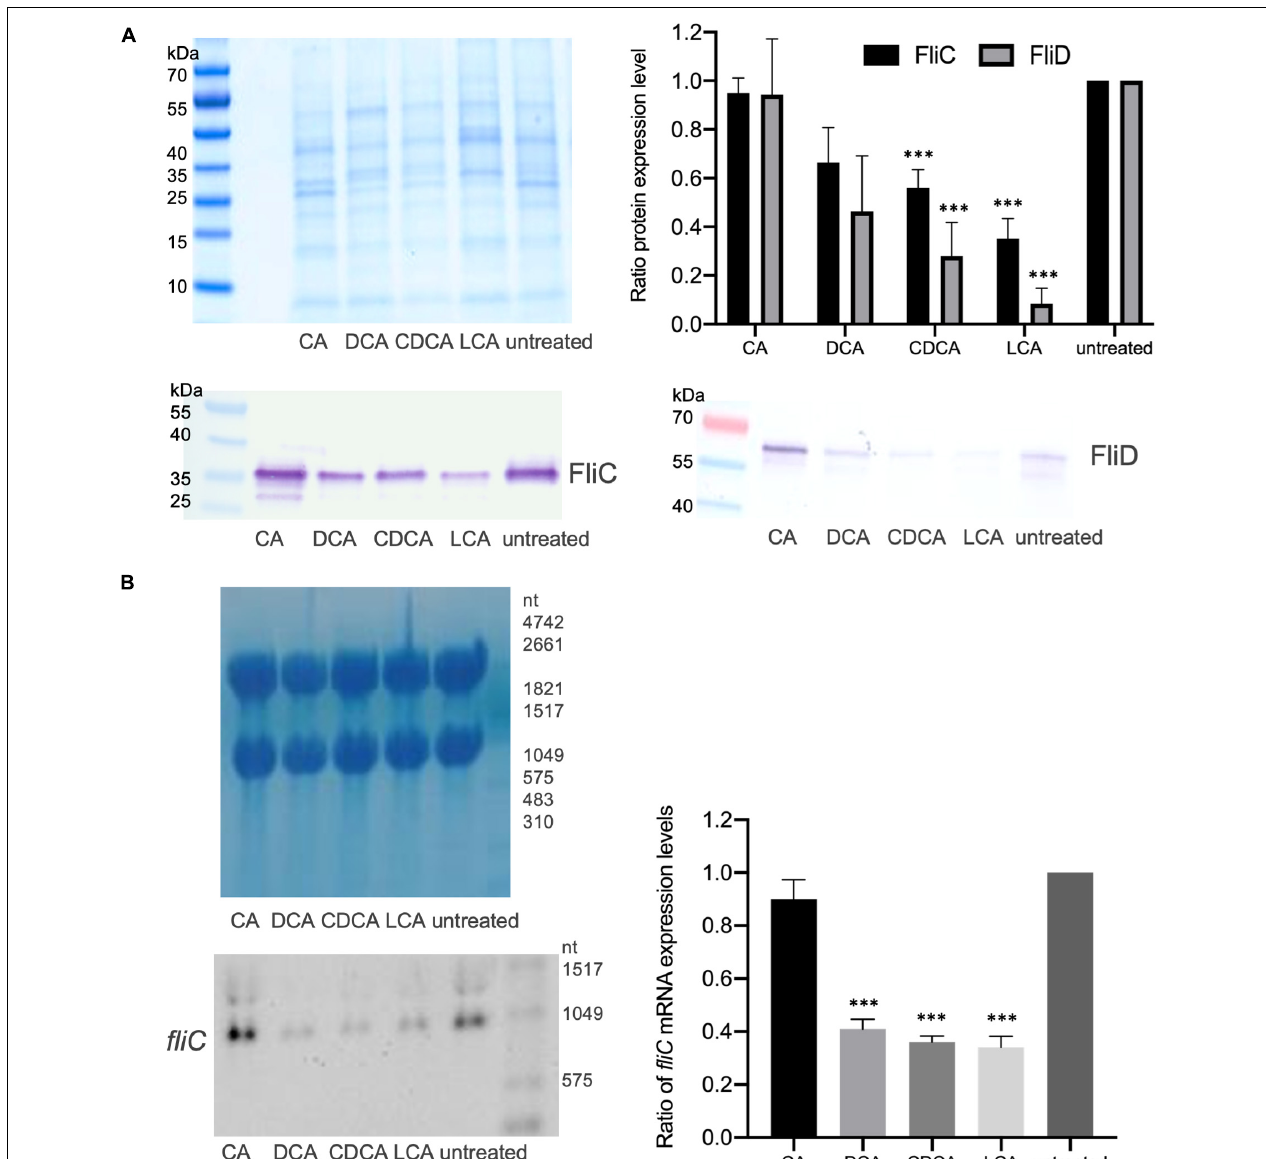
FIGURE 2 | Flagella protein expression. (A) Western Blot analysis of FliC and FliD expression in untreated cells and in cells stressed with the four different BAs with a Coomassie-stained gel in the upper left corner that was run as a loading control in parallel. Right (top): Average quantification of signal intensities of FliC as well as FliD bands of three replicates normalized to untreated condition. (B) Transcriptional profiling of fliC expression by Northern Blotting. Left (top): Methylene blue staining of RNA gel serving as a loading control. Left (bottom): Exemplary fliC -specific Northern Blot. Right: Three biological replicates were analyzed and normalized to the control condition. Standard deviation is indicated and values significantly different by a Student’s t -test compared to untreated cells are marked ( ∗∗∗ p -value <